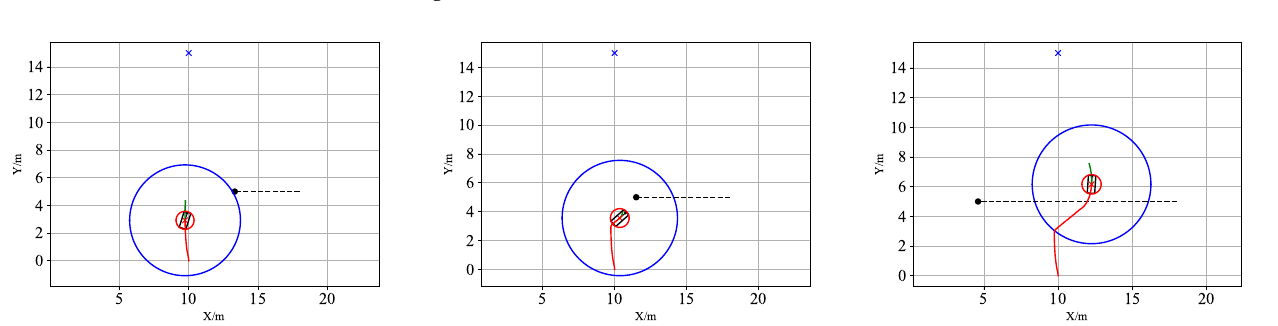
Figure 26. Crossing situation for the improvement of weighting coefficients based on fuzzy control.